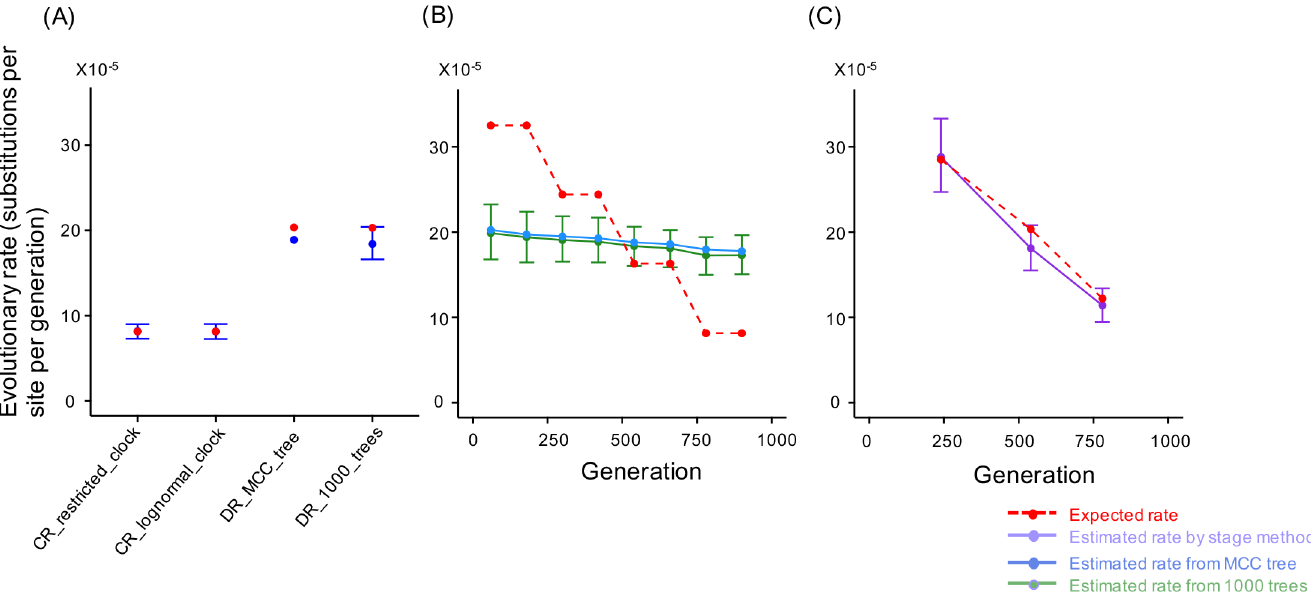
Fig 3. The stage method is better than the time-bin method for estimating evolutionary rate dynamics. (A) The evolutionary rate for the constant- rate (CR) dataset was estimated using both restricted and relaxed log-normal clock models (labeled CR_restricted_clock and CR_lognormal_clock respectively). The estimated mean evolutionary rates from the two models are in good agreement. The mean evolutionary rates of the decreasing rate (DR) dataset estimated from the MCC tree and the 1000 time scaled Bayesian trees (labeled DR_MCC_tree and DR_1000_tree respectively) are highly consistent with the expected rates (red dots) derived from the calculated evolutionary rate of the CR dataset (see Materials and Methods). (B) The mean evolutionary rates for the eight time bins of the DR dataset were estimated from a single MCC tree (blue) and the mean and the 95% highest probability density (HPD) intervals estimated from 1000 time scaled Bayesian trees (green). The estimated evolutionary rates for each bin are significantly different from the expected rate (red). (C) The expected rates (red) of the three stages of the DR dataset are within the estimated 95% HPD of the mean evolutionary rates (purple), suggesting the stage method is reliable for characterizing evolutionary rate changes over time.